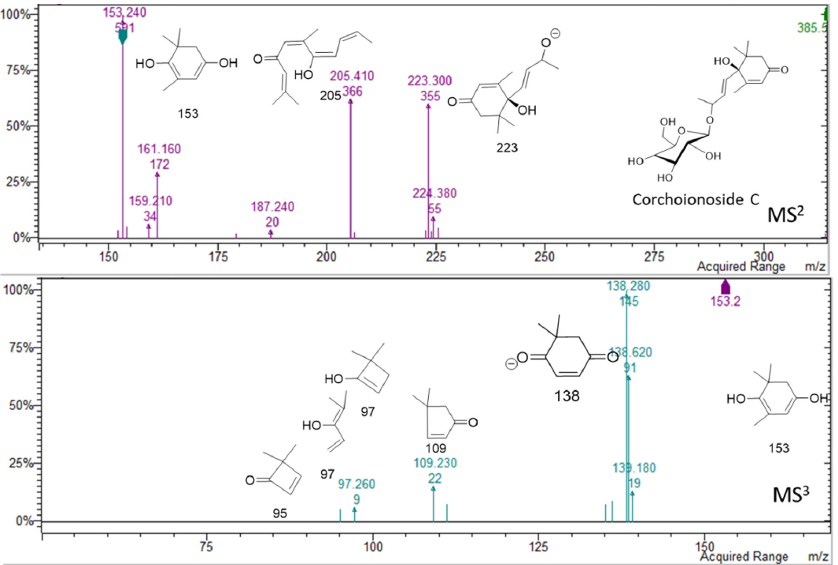
Figure 6. Spectra and fragmentations proposed for corchoionoside C: MS 1 from parent ion 385 m/z , MS 2 from fragment 153 m/z.